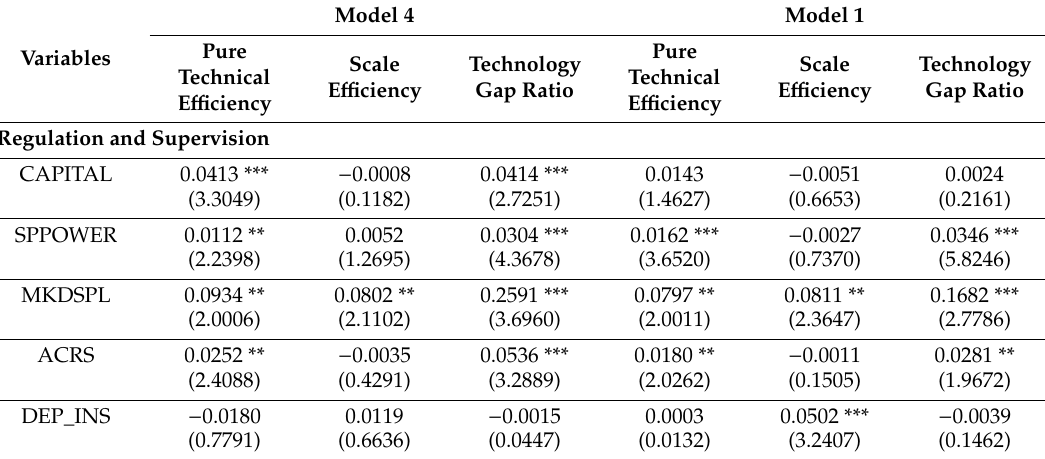
Table 8. Bootstrap truncated regressionrResults: Full sample